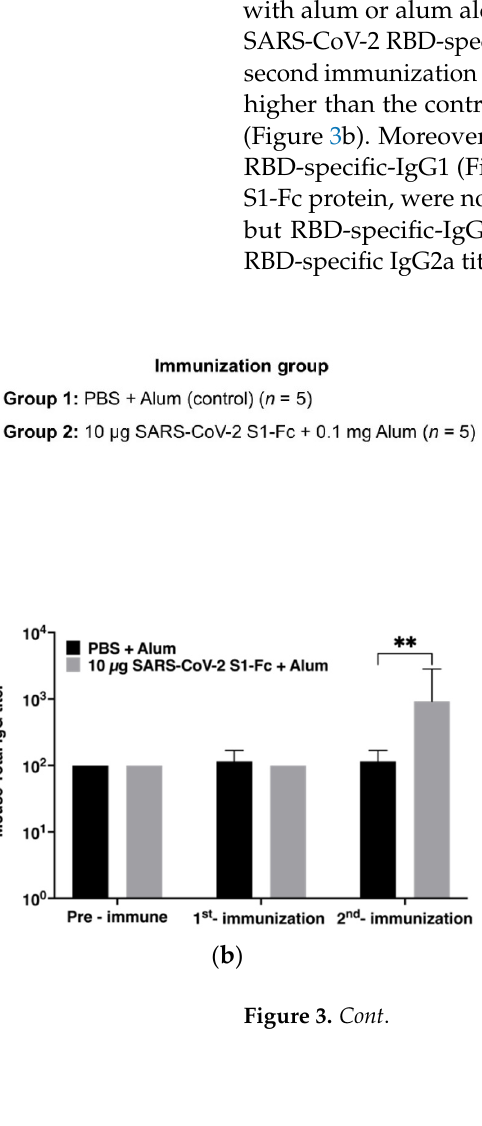
Figure 3. Mice immunogenicity studies. Diagrammatic illustration of immunization procedure and sample collection. Groups of mice ( n = 5) were immunized with 10 µg of SARS-CoV-2 S1-Fc protein adjuvanted with alum on days 0 and 21. Mice sera were obtained on days 0, 14, and 35 ( a ). Titers of SARS-CoV-2 RBD-specific mouse ( b ) total IgG, ( c ) IgG1, ( d ) IgG2a, and ( e ) the ratio of SARS-CoV-2 RBD-specific mouse IgG1/IgG2a titer at indicated time-point. Data presented as geometric mean ± 95% CI of the endpoint titers in each group, n = 5. Two-way ANOVA, Tukey test, was used (**: p < 0.01). 3.4. IFN- γ ELISpot Assay The immunized mice splenocytes were isolated and evaluated for RBD-specific IFN- γ secretion using IFN- γ ELISpot assay on day 35. The findings showed that compared to the control group, the plant-produced SARS-CoV-2 S1-Fc considerably increased the IFN- γ secretion with p < 0.01 (Figure 4, Table S1).